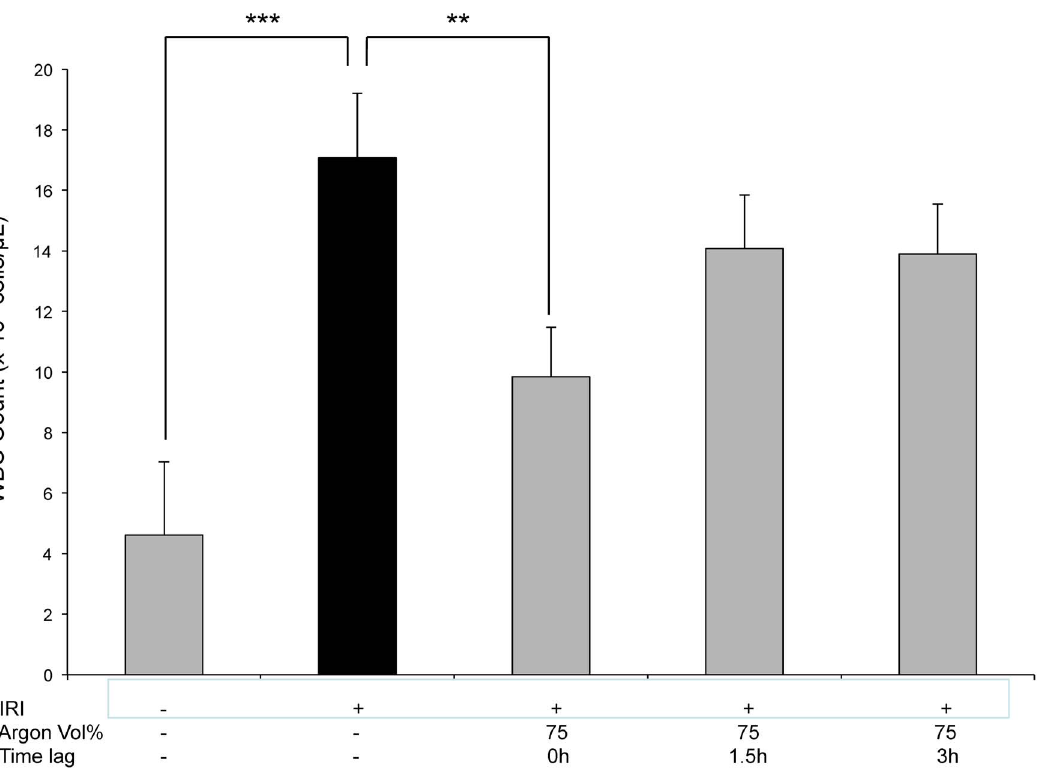
Fig. 6. White blood cell count in peripheral blood after IRI and Argon postconditioning. (n 5 8; data are expressed as mean cell counts ( 6 10 3 / m L) ¡ SD; *** 5 p , 0.001 untreated vs. IRI and ** 5 p , 0.01 IRI vs. IRI + Argon